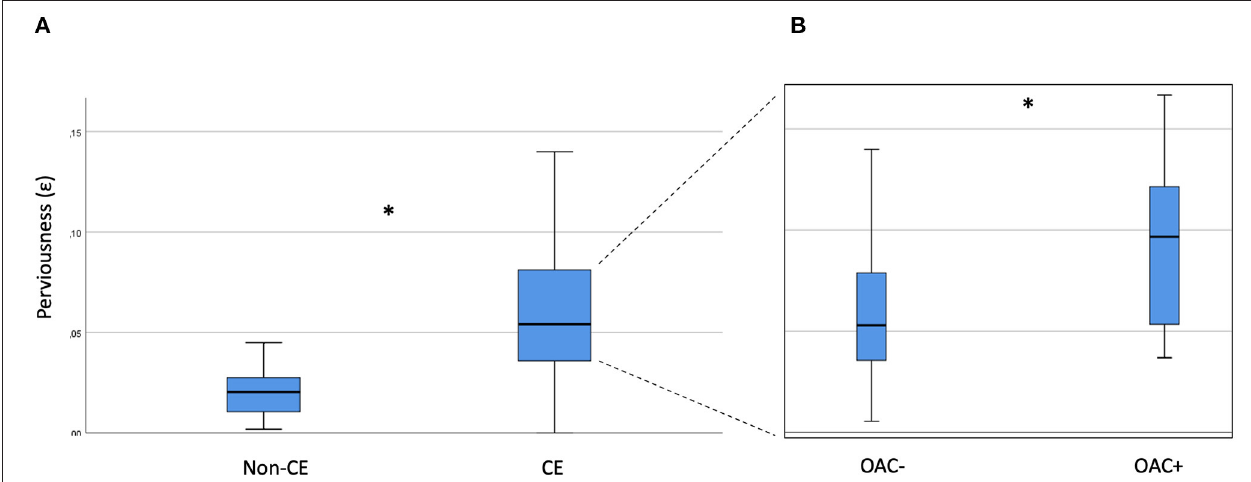
FIGURE 3 | Thrombus perviousness of non-cardioembolic and suspected cardioembolic thrombi with focus to prior anticoagulation. (A) Comparison of non-cardioembolic (Non-CE) and suspected cardioembolic (CE) thrombi. (B) Among cardioembolic thrombi comparison of thrombi without (OAC–) and with (OAC + ) prior anticoagulation. * indicates p < 0.05.